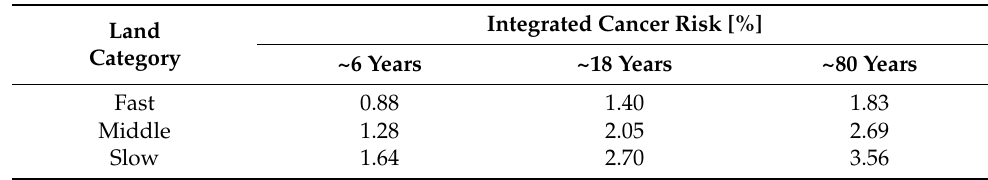
Figure 3. Predicted integrated cancer-mortality risk induced by γ -rays from 137 Cs deposited onto ground for a female infant (0 years old) at the initial dose rate of 20 mGy y − 1 .